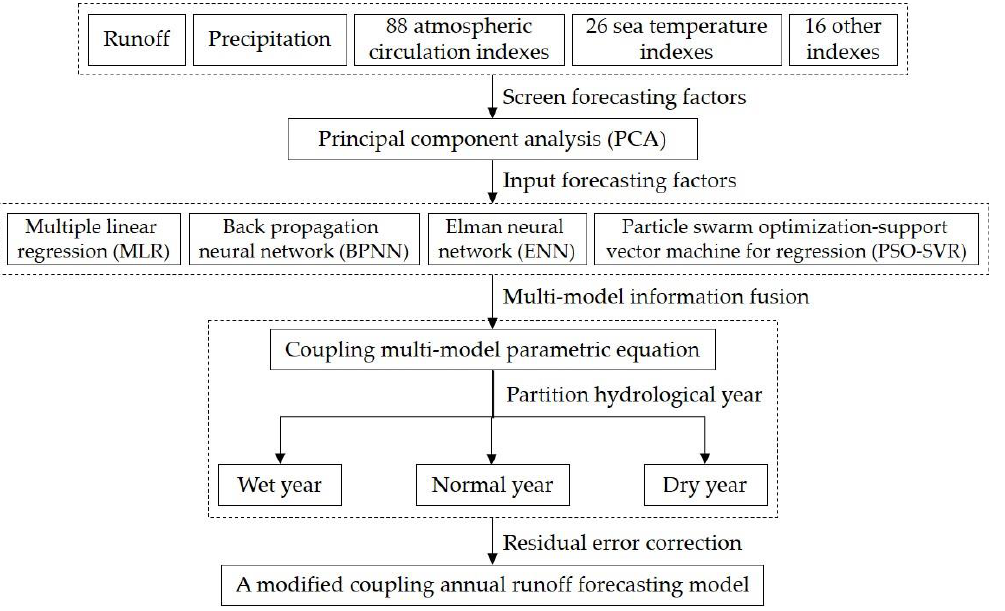
Figure 2. Technique flow chart of annual runoff forecasting.